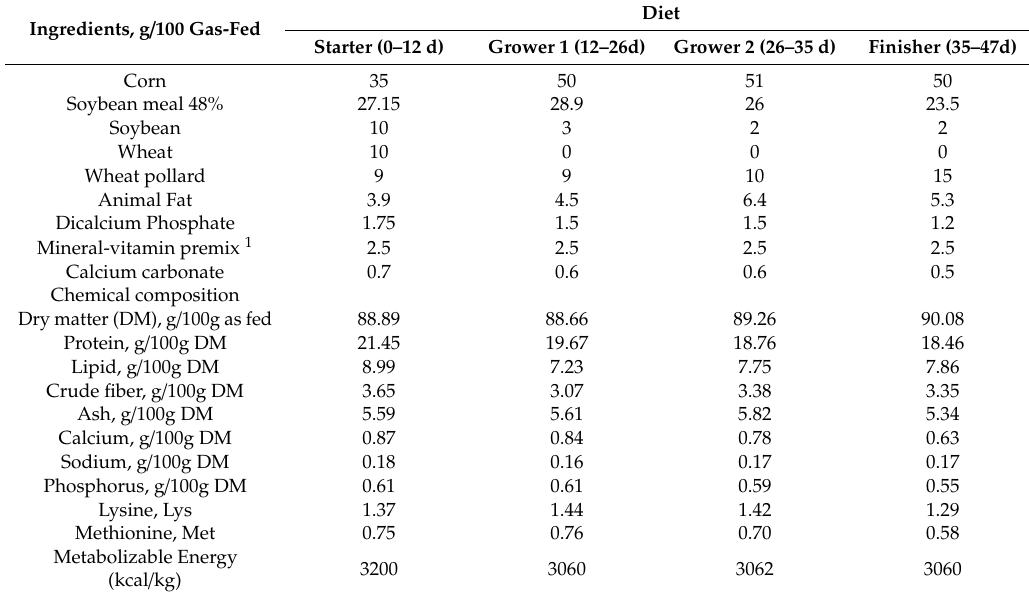
Table 1. Ingredients and chemical composition of the experimental